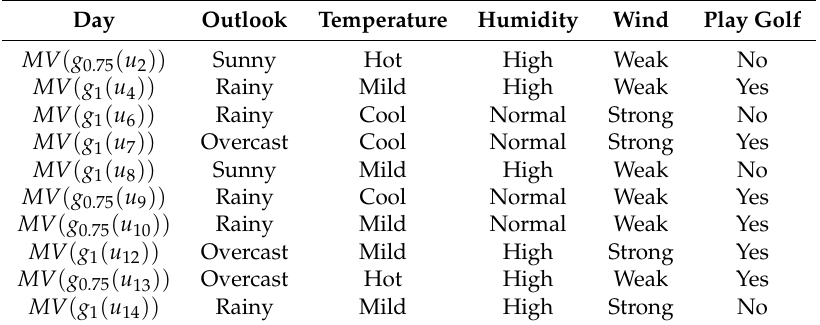
Table 6. Homogeneous granular decision system formed from covering